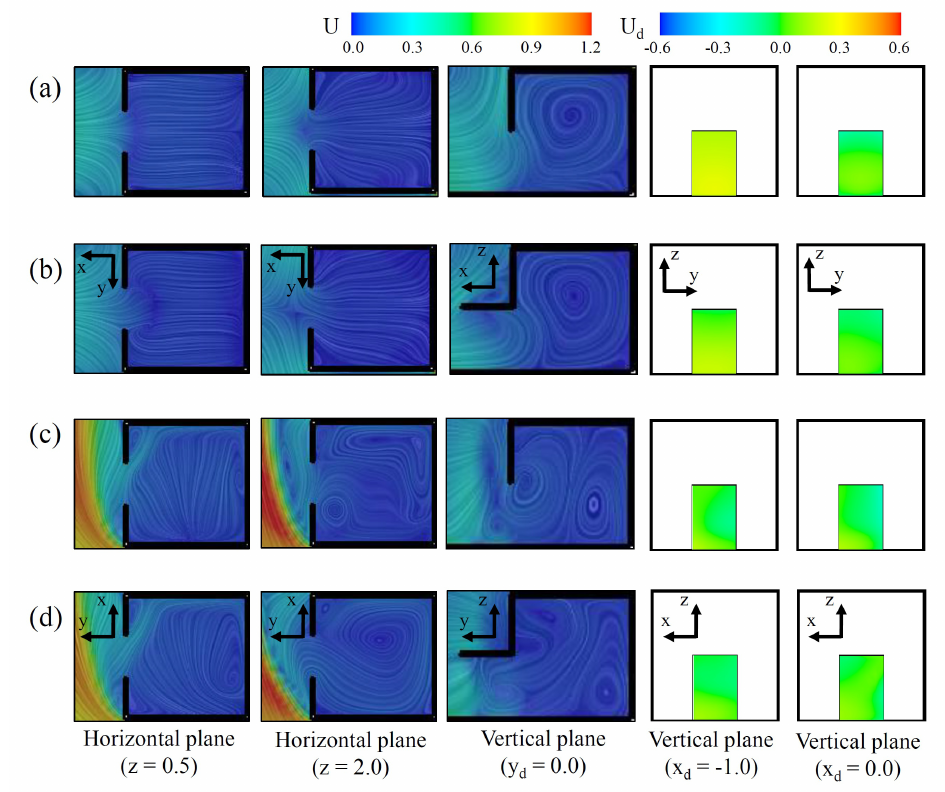
Figure 9. Contour plots of the time-averaged velocity magnitude along with streamlines and the velocity normal to the entrance: for the single-sided building ( a ) without an overhang and ( b ) with the overhang ( L / D = 0.8 ) in the leeward direction, and for the single-sided building ( c ) without an overhang and ( d ) with the overhang ( L / D = 0.8 ) in the side